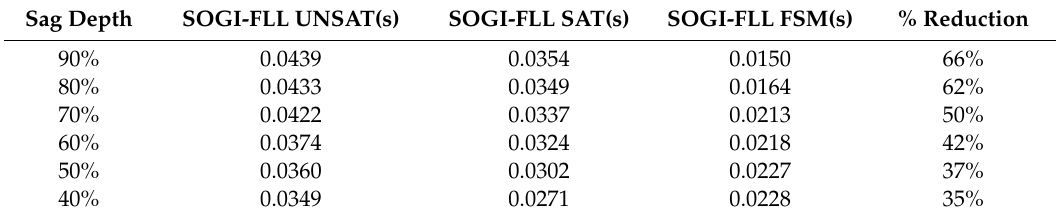
Table 4. Recovery times of the di ff erent SOGI-FLL schemes for various voltage sag depths. Sag Depth SOGI-FLL